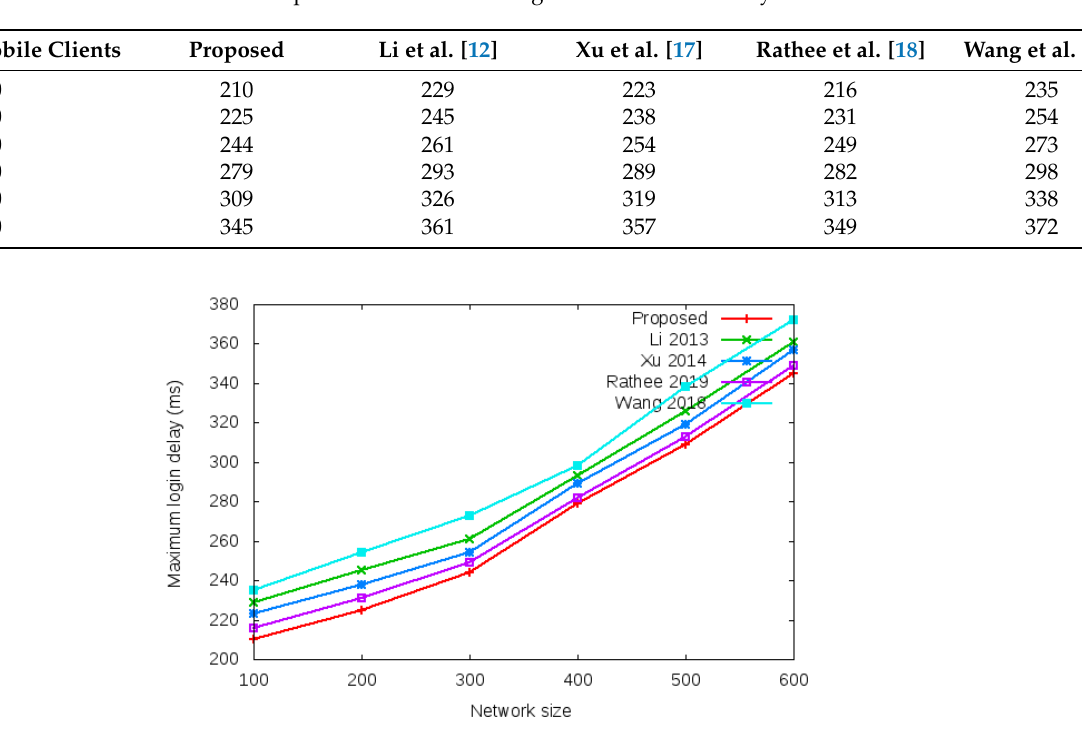
Table 7. Comparison on maximum login authentication delay.